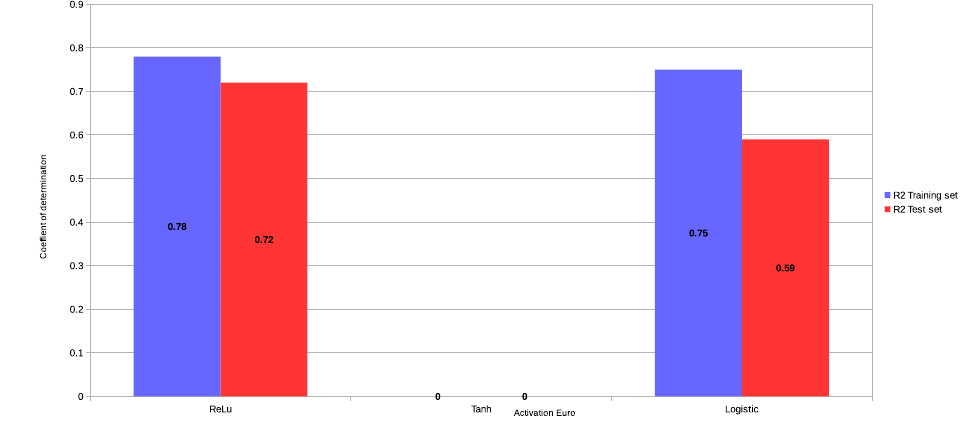
Figure 2. Regression model for interior point method—tuning the activation function. Table 3. MLPRegressor model parameters used for primal and dual simplex